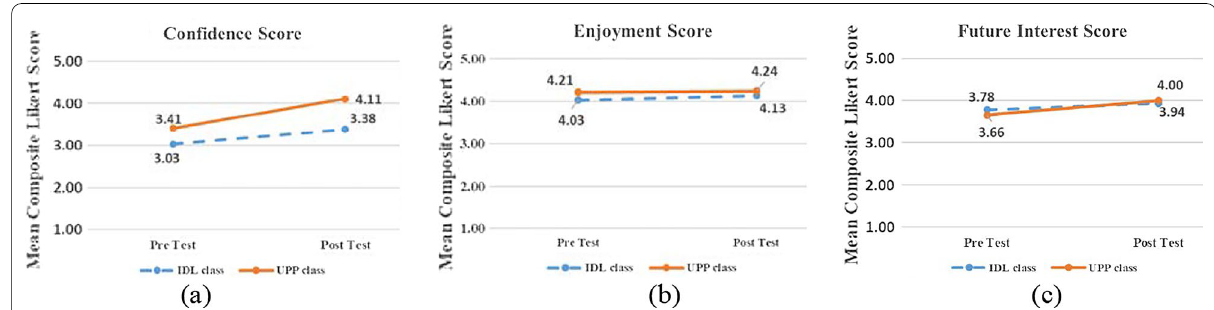
Fig. 4 Scores of learners’ confidence ( a ), enjoyment ( b ) and future interest ( c ) in two instructional modes